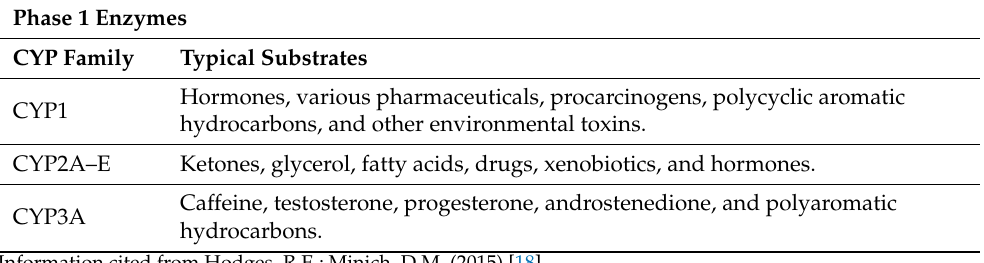
hydrocarbons, and other environmental toxins.